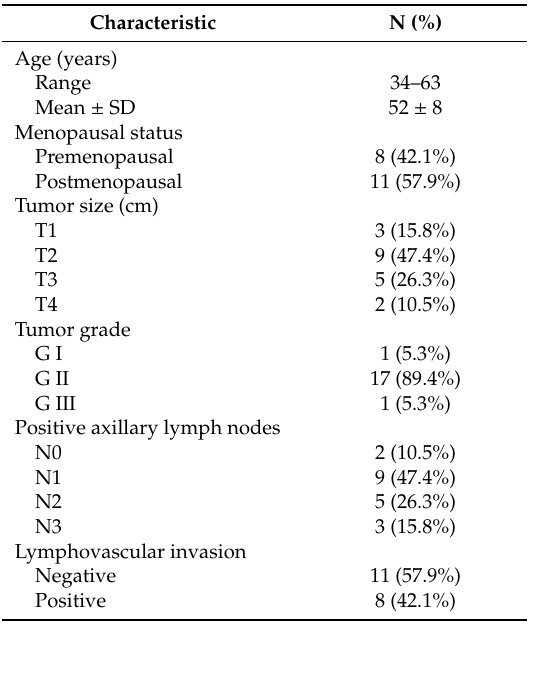
Table 1. Patient characteristics. N = number, SD = standard deviation.